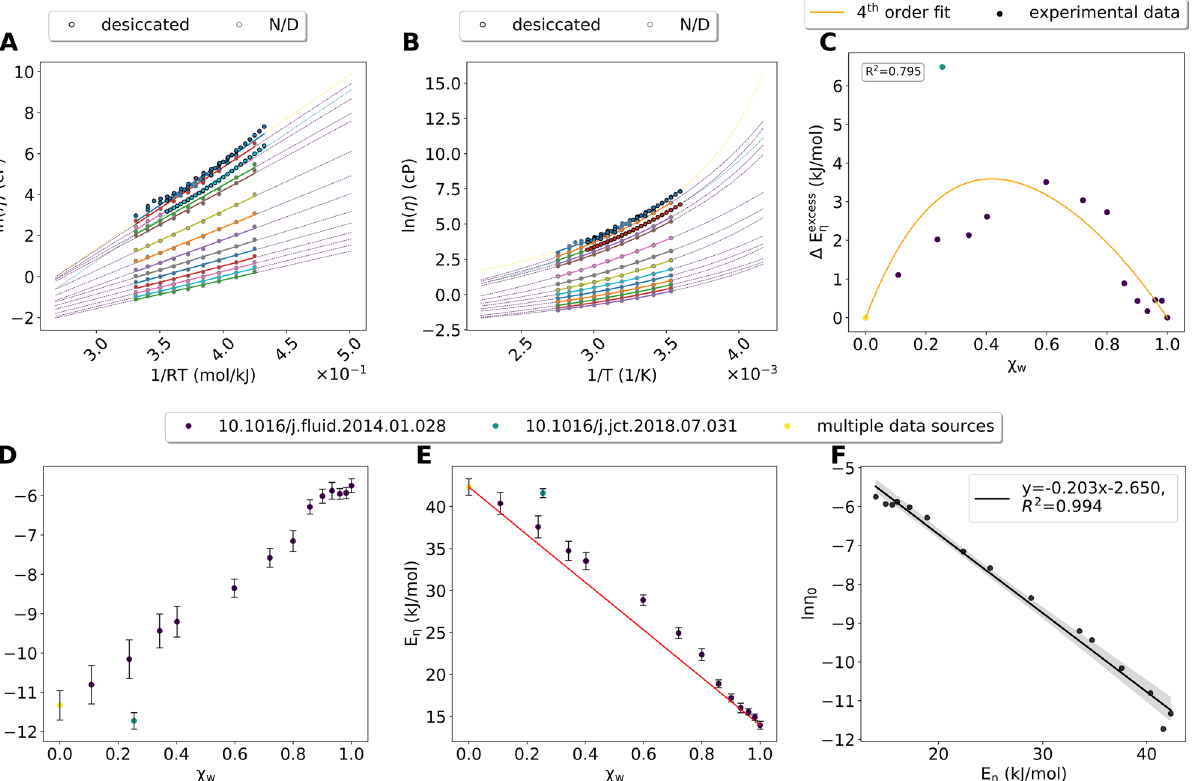
Figure 2. Glyceline–water mixtures. ( A ) Arrhenius fits (using a minimum of 3 data points). Dots and thick lines are the experimental data and the respective fit. The dashed lines are extensions of the fit. Colors of the dashed lines indicate the source of the data. Yellow: multiple data points from different sources were be excess combined. ( B ) VFT fits using a minimum of 4 data points. ( C ) E η , calculated based on the red line in ( E ). Colors of the data points indicate the source of the data. ( D ) ln η 0 at different χ w . Error bars are calculated based on the fit in ( A ). Colors of the dashed lines indicate source of the data. ( E ) E η at different χ w , same logic as ( D ). excess The red line indicates the behavior of an ideal binary mixture and was used to calculate E η . ( F ) Correlation between ln η 0 and E η